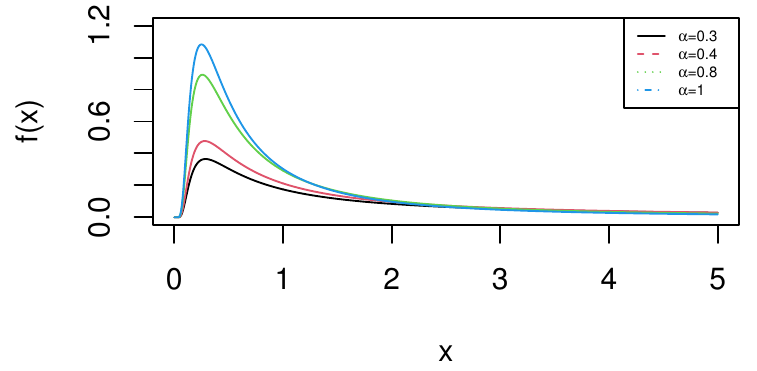
Figure 3. Graph of the PDF of GIED for λ = 0.5.